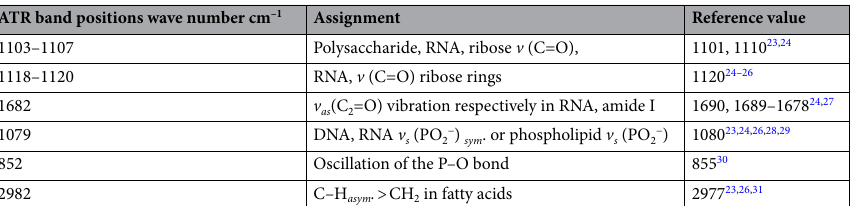
Table 2. Major band position elevated in rheumatoid arthritis patients along with the assignment of the bands.